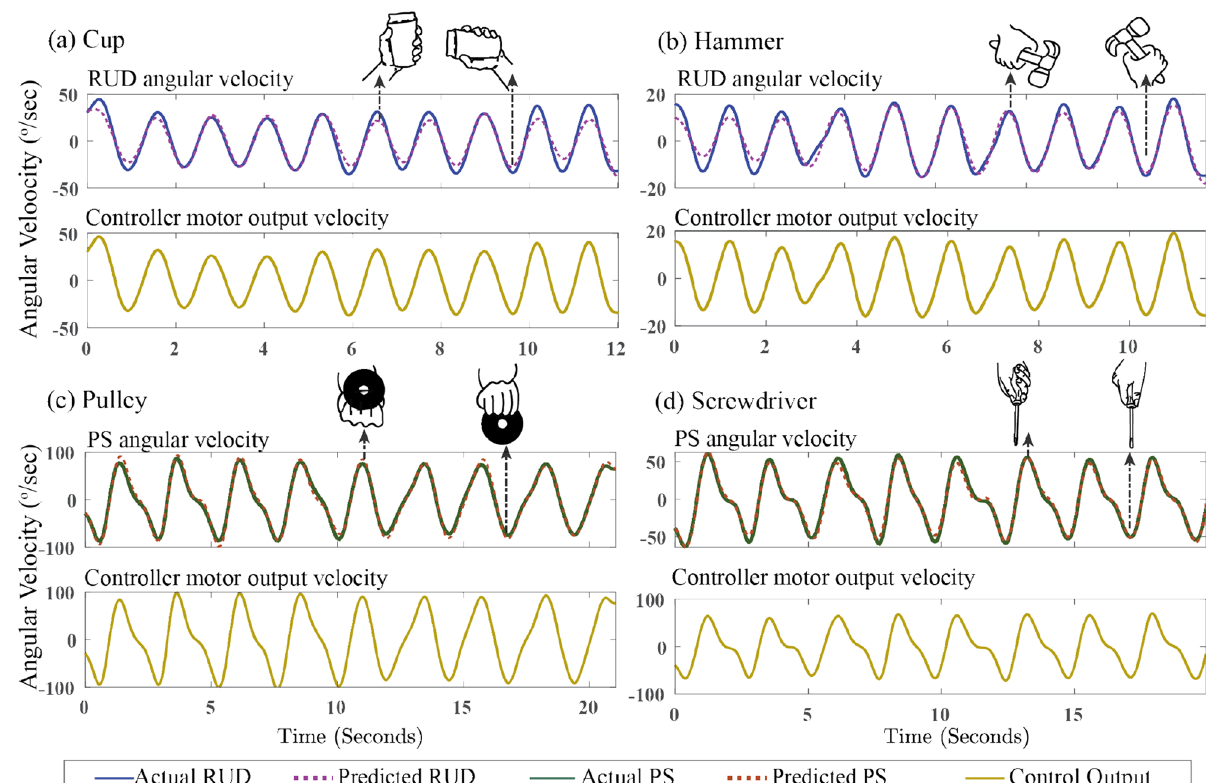
Figure 3. Measured Vs Predicted angular velocity and the controller generated angular velocity for one representative participant during each task. (a) Cup and (b) hummer tasks are designed for radial/ulnar deviation. (c) pulley and (d) screw driver tasks are designed for